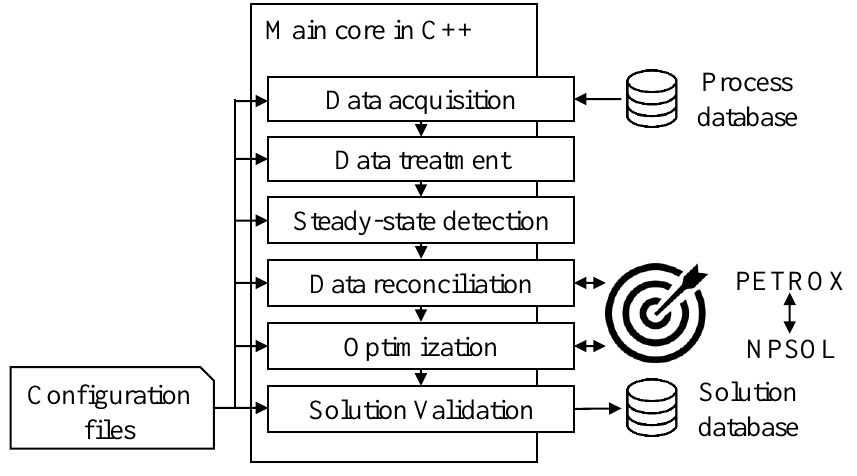
Figure 2. Scheme of the SoraIA